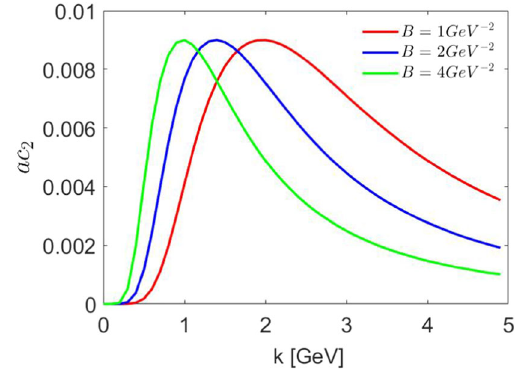
Fig. 4 The cumulant ac 2 for N = m = 3 , N c = 3, k 1 = k 2 = k 3